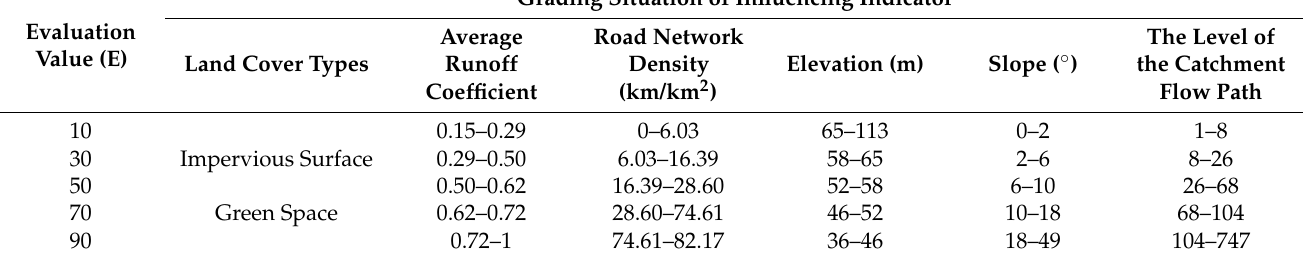
Table 6. Grading situation and evaluation values of influence indicators in the selection of a multi- functional rainwater storage space site.